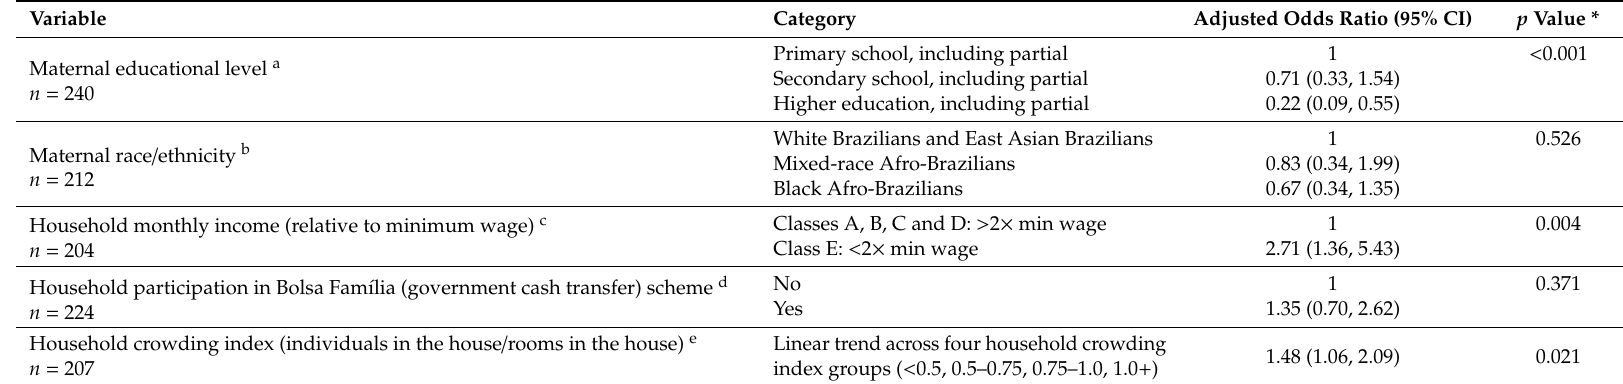
Table A2. Multivariate associations of socioeconomic indicators with microcephaly cases in children with and without qRT-PCR or IgM confirmation with suspected prenatal ZIKV exposure ( n =